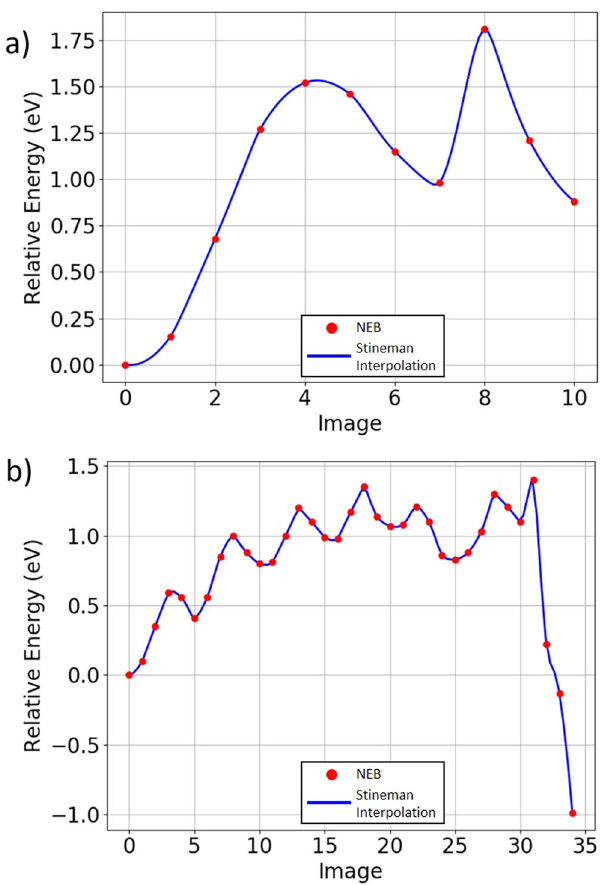
Fig. 6 Nudged elastic band (NEB) calculations of stacking fault